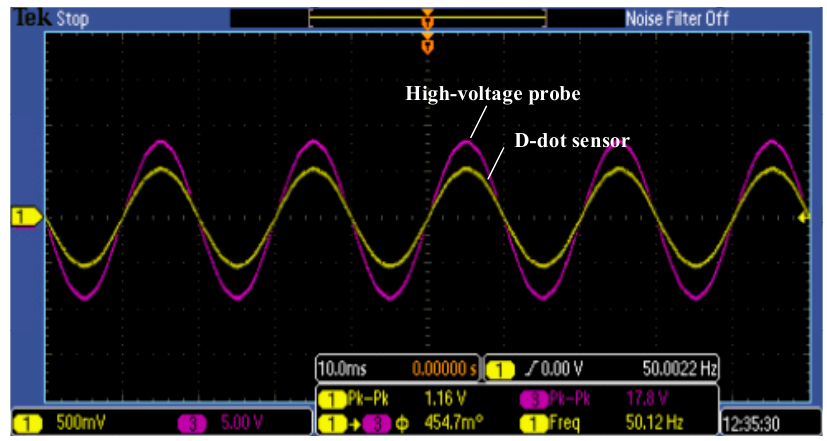
Figure 10. Comparison of outputs between the D-dot sensor and high-voltage probe.